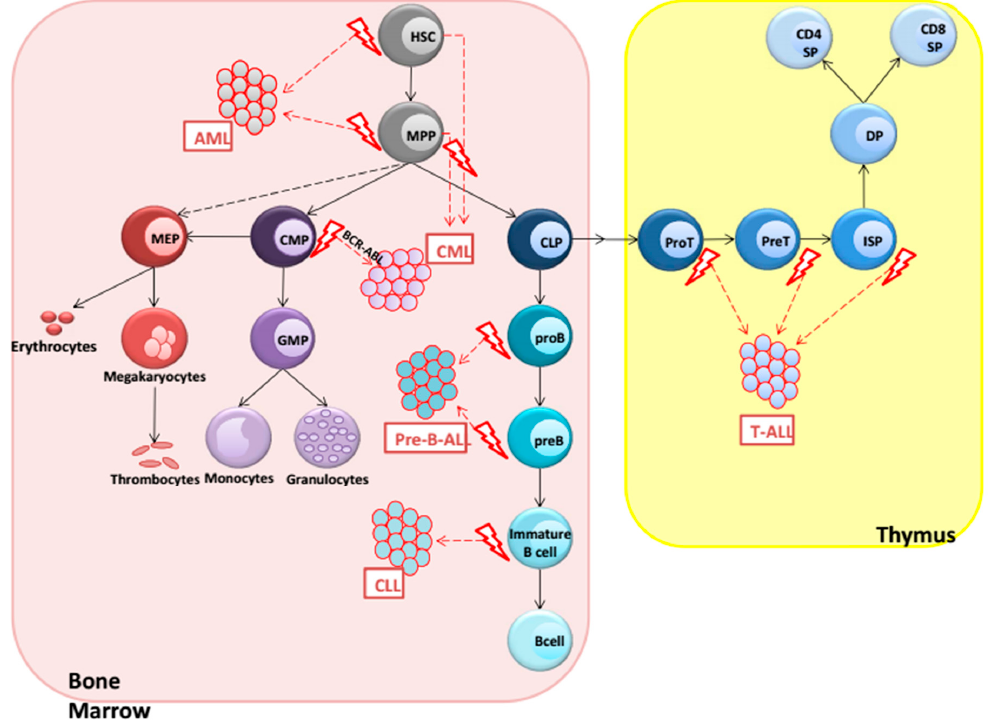
Figure 2. Leukemia development in humans. Leukemias are shown as malignant counterparts from normal hematopoietic cells. The figure is drawn to stress the similarities, not differences. For details on Wnt signaling in the various types of leukemia, see the main text. Wnt signaling in the various types of leukemia, see the main